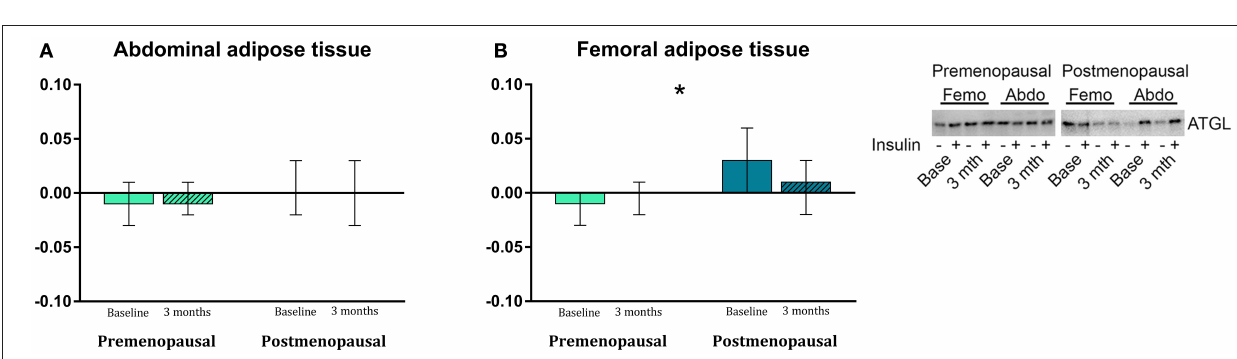
MRI scans: Abdominal subcutaneous and visceral adipose tissue masses did not differ between the pre- and the post- menopausal women and a dipose tissue masses decreased similarly in the two groups after the intervention ( p < 0.005